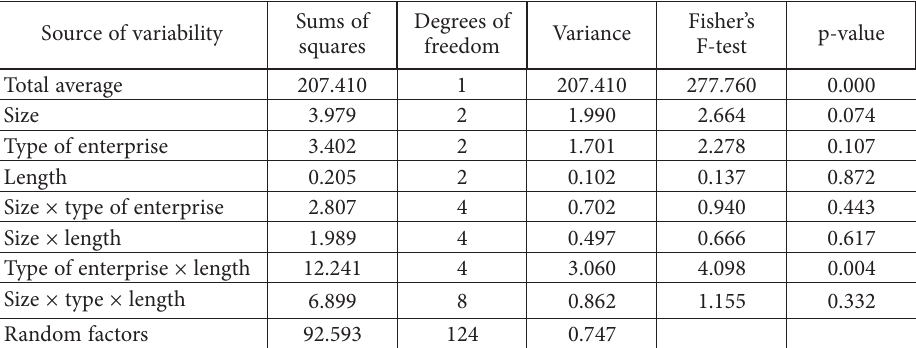
Table 7. Three-factor analysis of variance